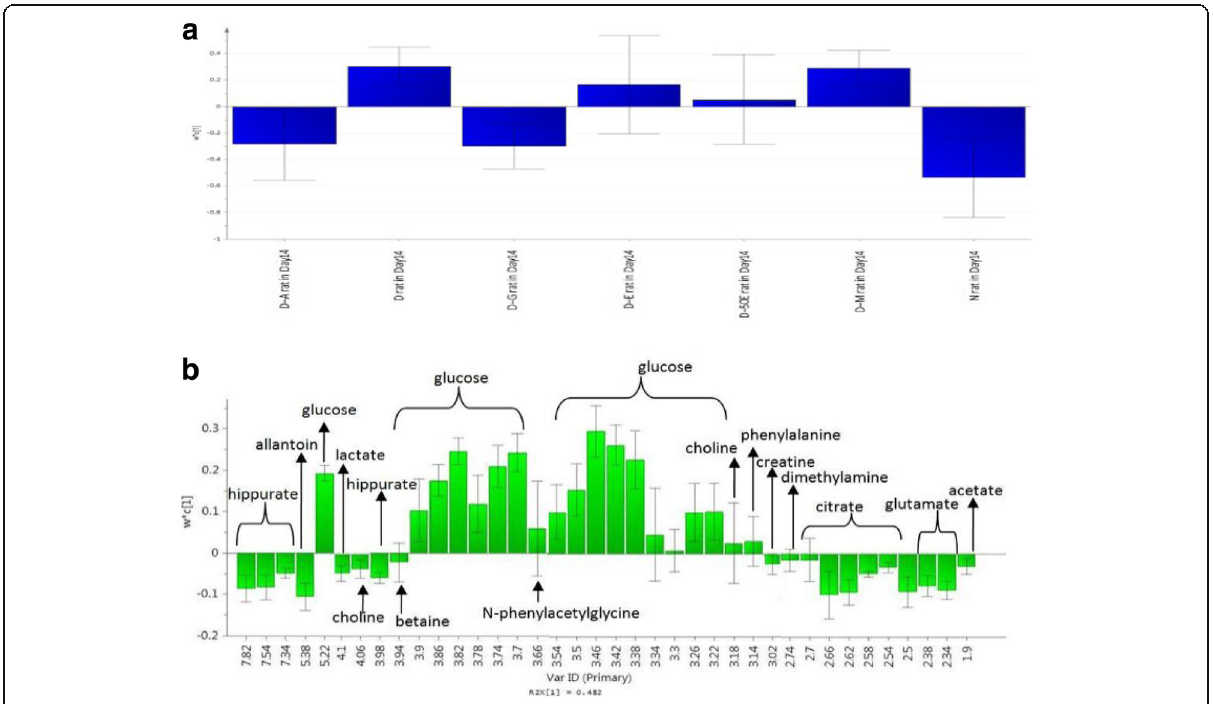
Fig. 3 Loading column plot of PLS-DA component 1 in day 14 ( a ) based on class ( b ) based on